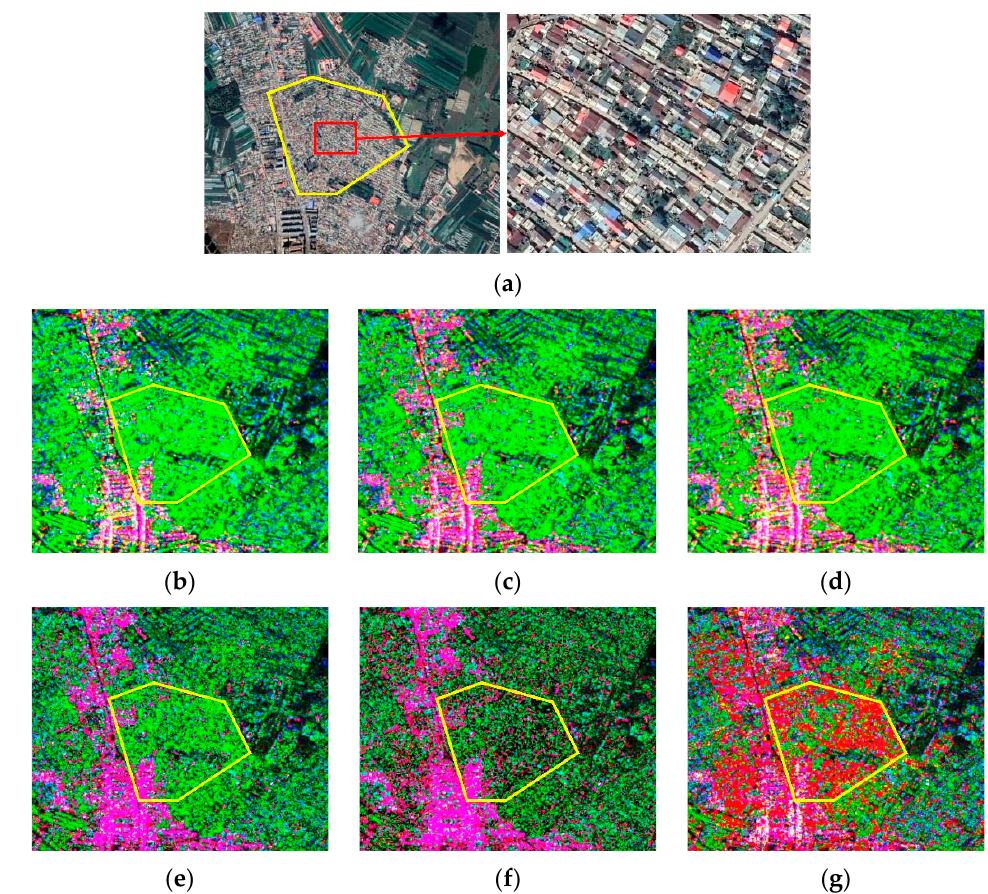
Figure 13. Enlarged view of Patch B3 ( a ) optical image, ( b ) Y4O, ( c ) Y4R, ( d ) G4U, ( e ) 6SD, ( f ) 7SD, ( g ) MRDM-5SD (RGB component: red: double-bounce scattering, green: volume scattering, blue: surface scattering).